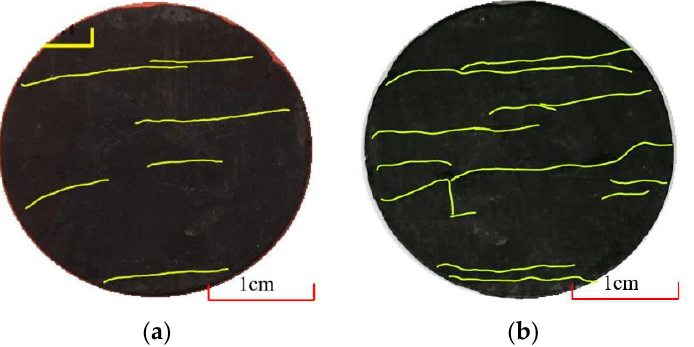
Figure 8. A comparison of the development degree of cracks on the surface of sample N-52 before fracturing fluid imbibition and after flowback. ( a ) Before imbibition and ( b ) after flowback.